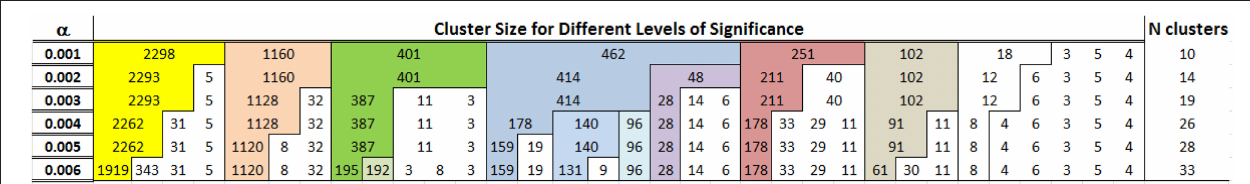
FIGURE 7 | Clusters detected by cutting the dendrogram using different percentiles of the the reference distribution D e in the LLFS data. The first p where p was used to determine the percentiles of the reference distribution D e . The other columns report the size of column shows the significance level α 1 = − different clusters and colors track clusters that are robust with respect to different percentiles. For example, the algorithm detects 10 clusters for α largest cluster in yellow includes 2298 profiles. The bulk of this cluster is maintained when the algorithm detects 14 clusters with α split into a cluster with 2293 profiles and a smaller cluster with only 5 profiles.